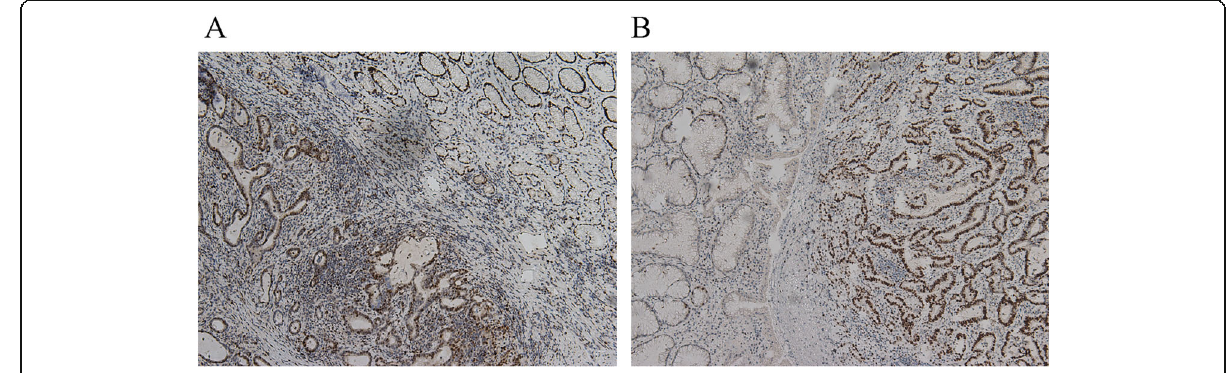
Fig. 5 Immunohistochemical test showed positive MSG2 ( a ) and MSH6 ( b